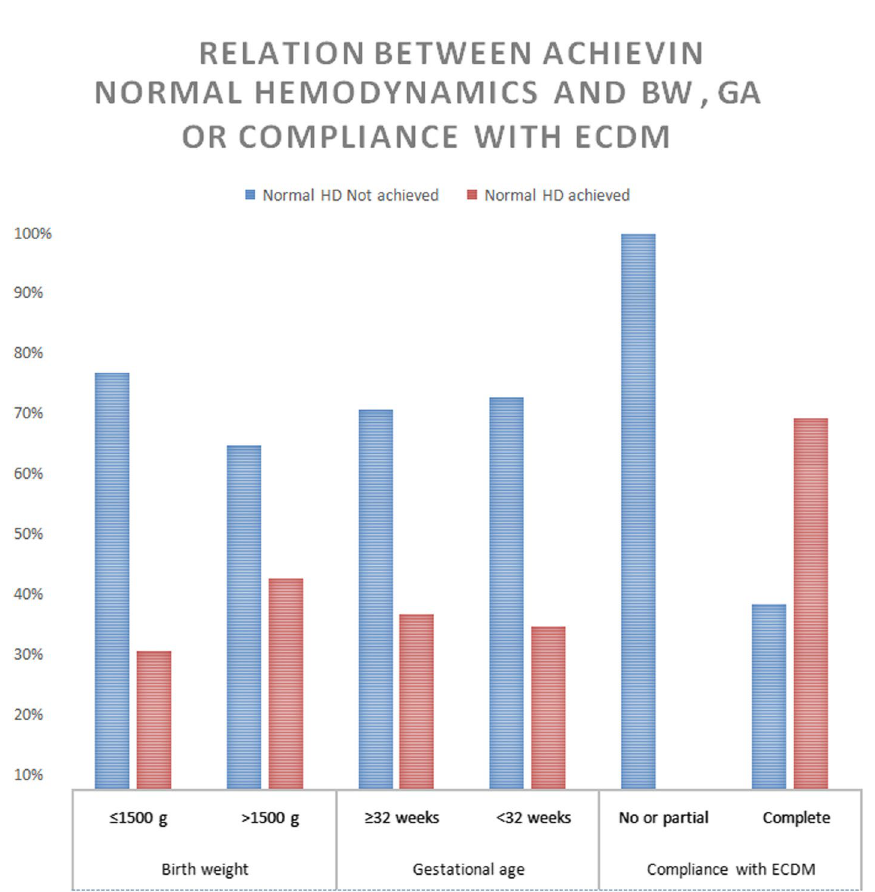
Fig. 4 Relation between the achievement of normal hemodynamics and birth weight, gestational age, or compliance with echocardiography‑directed management protocol in the study group. BW birth weight, GA gestational age, ECDM echocardiography‑directed management, HD